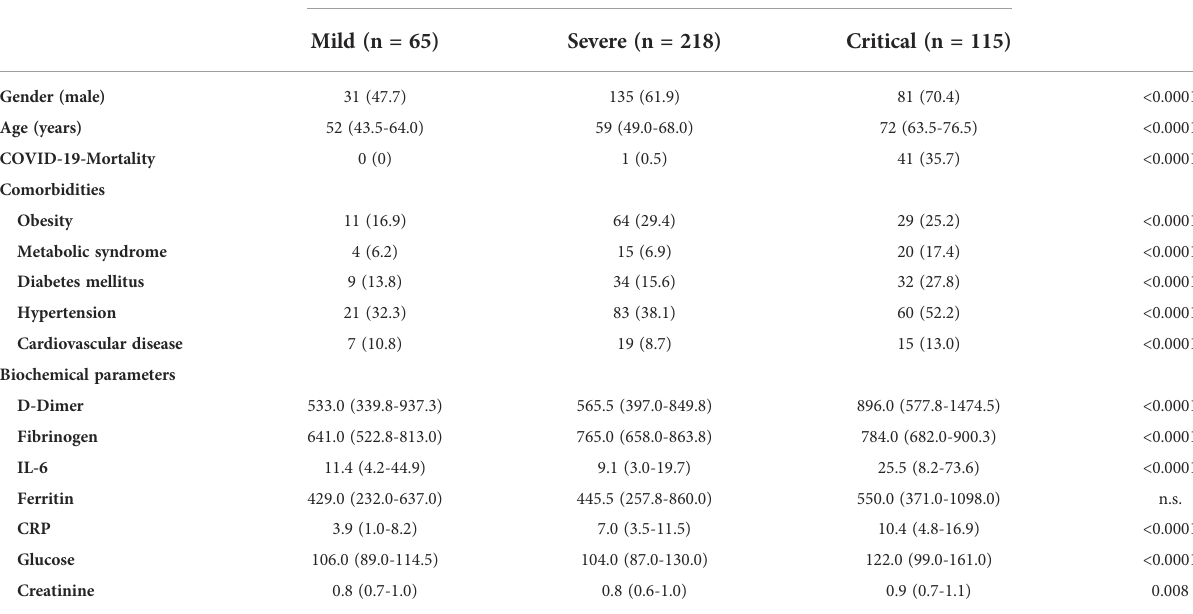
TABLE 2 Patient characteristics of COVID-19 cohort